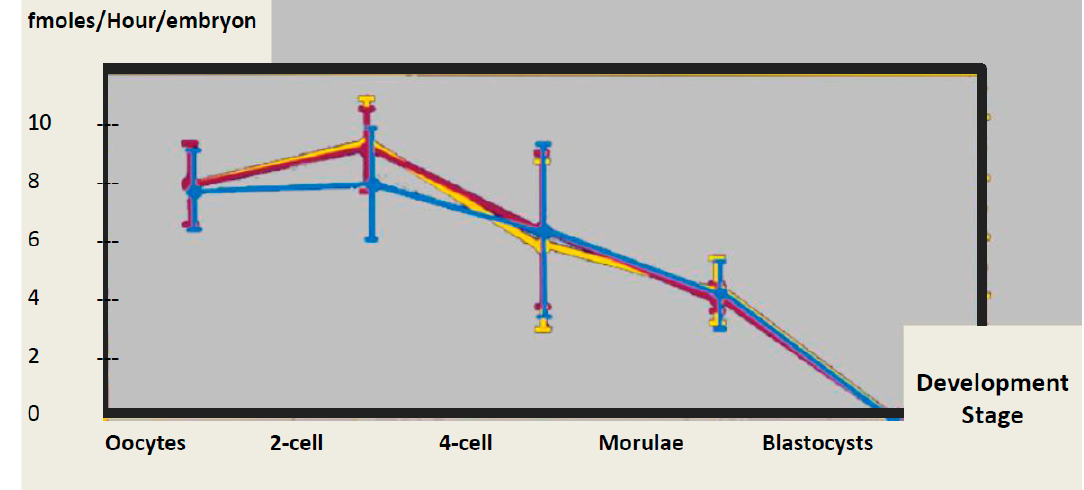
Figure 2. DNA methyl transferase activity in the mouse preimplantation embryo [32]. Yellow: caryogames, Blue: Ethanol activated parthenogenotes, Pink: Calcium ionophore activated parthenogenots.